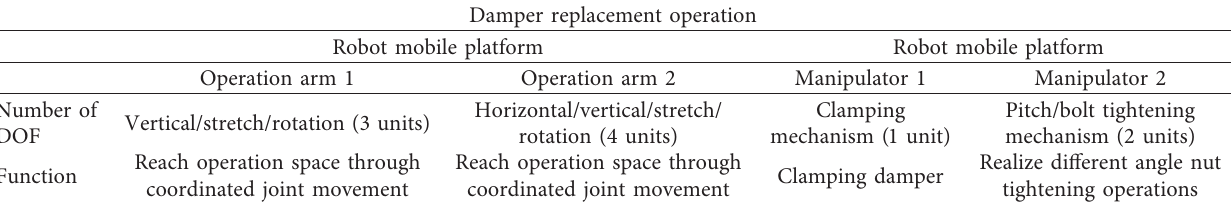
Table 3: The configuration analysis of the damper maintenance